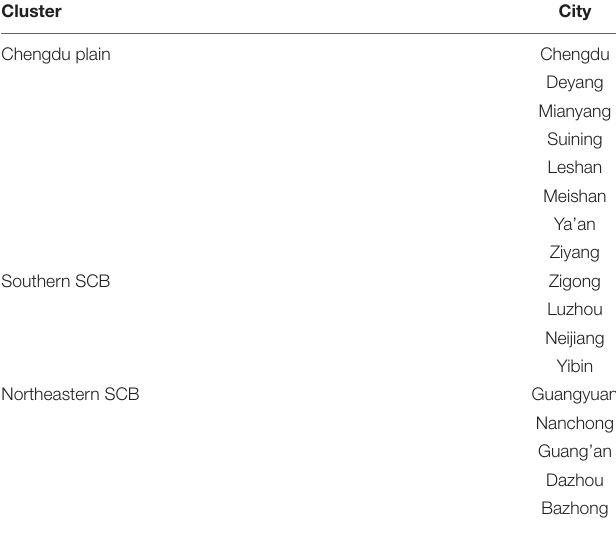
TABLE 3 | Classification of city clusters in the SCB.